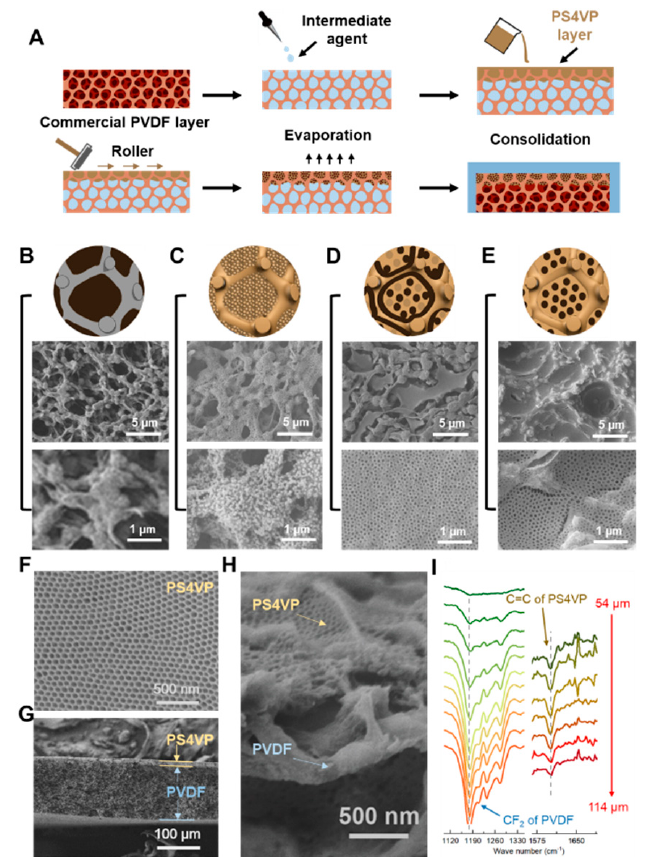
Figure 2. Fabrication and characterization of the PS4VP / PVDF Janus membrane. ( A ) Fabrication of the Janus membrane by SNIPS method. ( B – E ) FESEM images of PS4VP / PVDF membranes employing di ff erent ITAs. ( B ): pure PVDF and no ITA, ( C ): DMSO, ( D ): TEP, ( E ): DOX. ( F ) FESEM image of pure PS4VP membrane. ( G ) Cross-sectional FESEM images of PS4VP / PVDF Janus membrane. ( H ) Enlarged cross-sectional FESEM images of the layer filled with PS4VP of the Janus membrane. ( I ) FT-IR spectra of the PS4VP- filled PVDF layer, which show that the thickness is about 10 µ m and the length of the facula area is 50 µm.